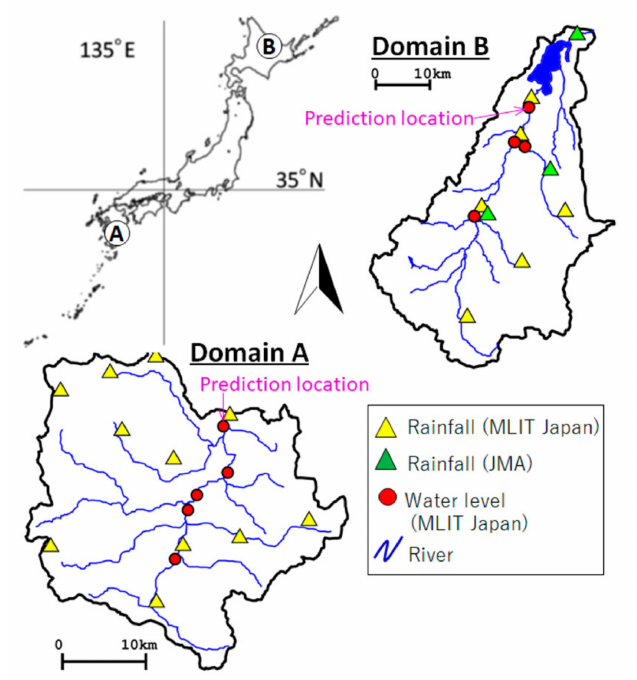
Figure 1. Maps of field sites: Domain A is part of the Oyodo River watershed, and Domain B is the Abashiri River